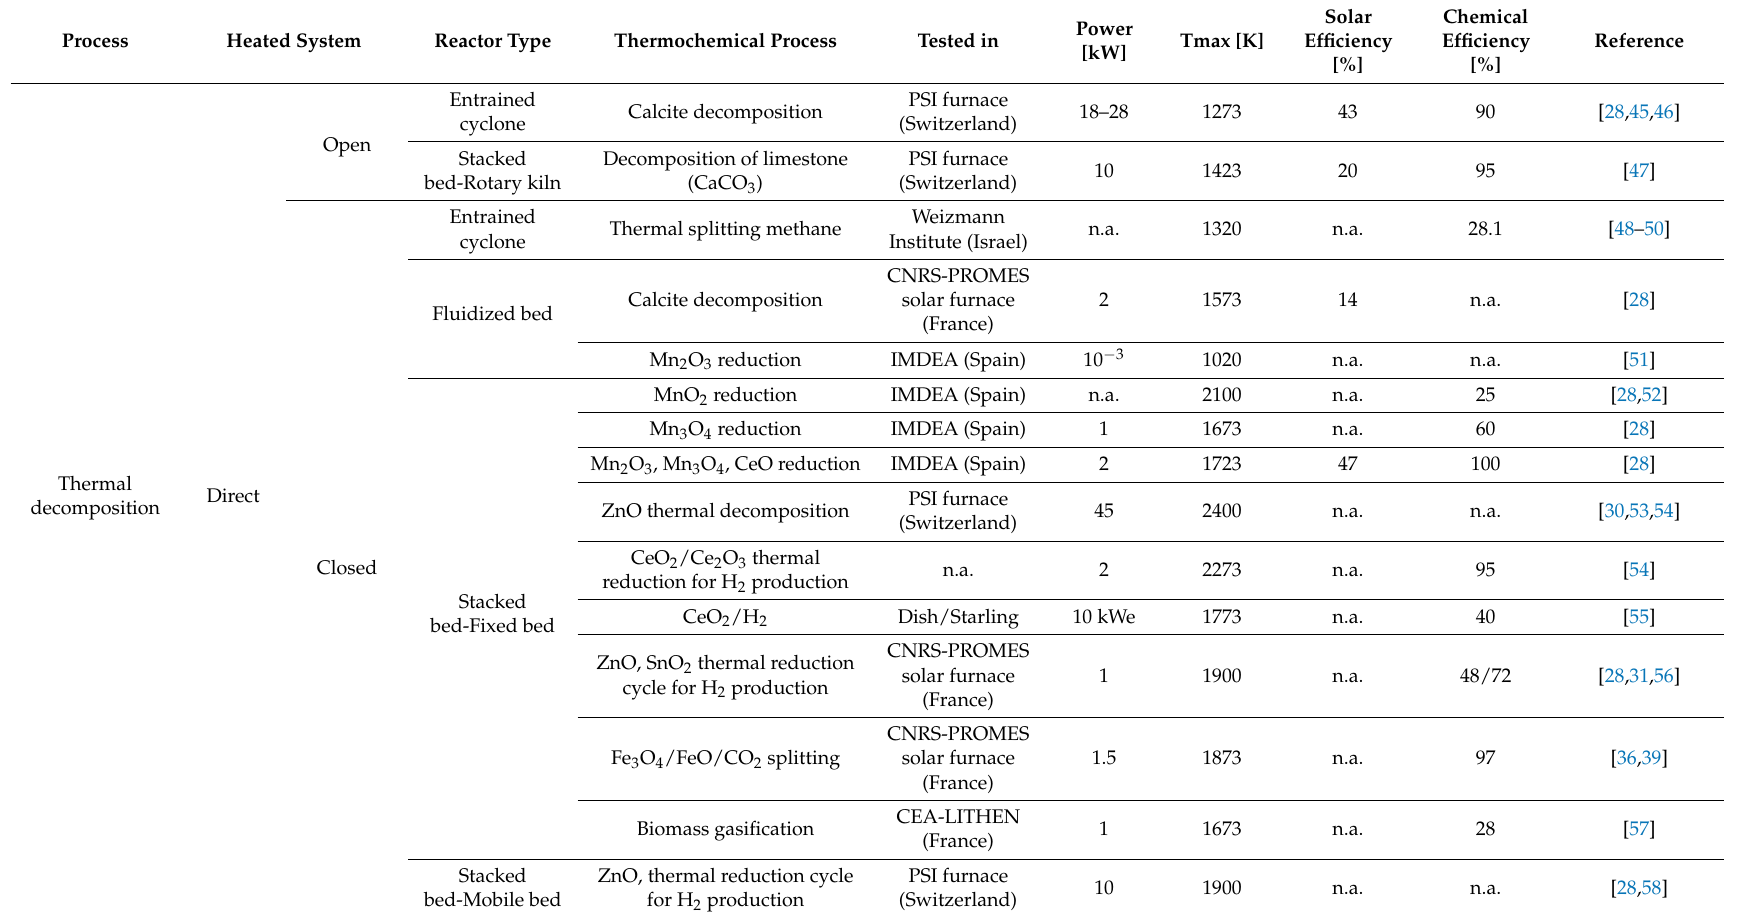
Table 2. Summary of reactor